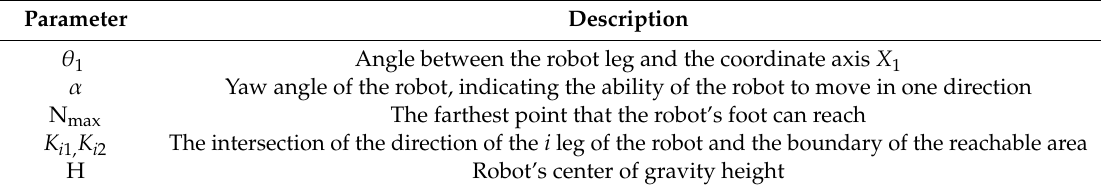
Figure 6. Reachable area of the robot foot. Table 4. The maximum step size of parameters.